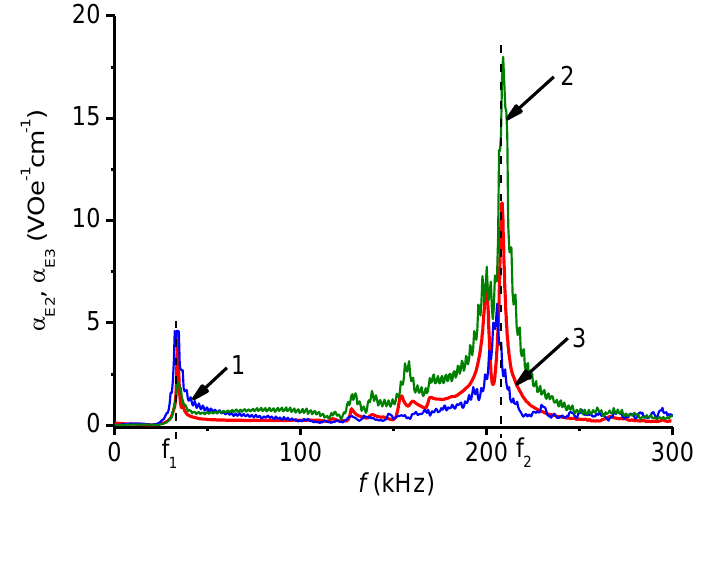
Figure 8. Dependence of the ME coefficients α CoFe/PZT structure measured by the pulse method (1,2) and by the HFM method (3). Curve 1 is obtained at Ĥ = 11.8 kOe and curve 2 at Ĥ = 38